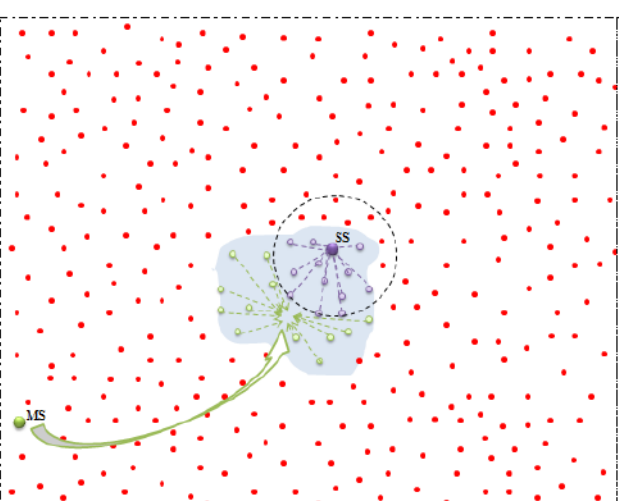
Figure 6. SS inside the event (MSmov).